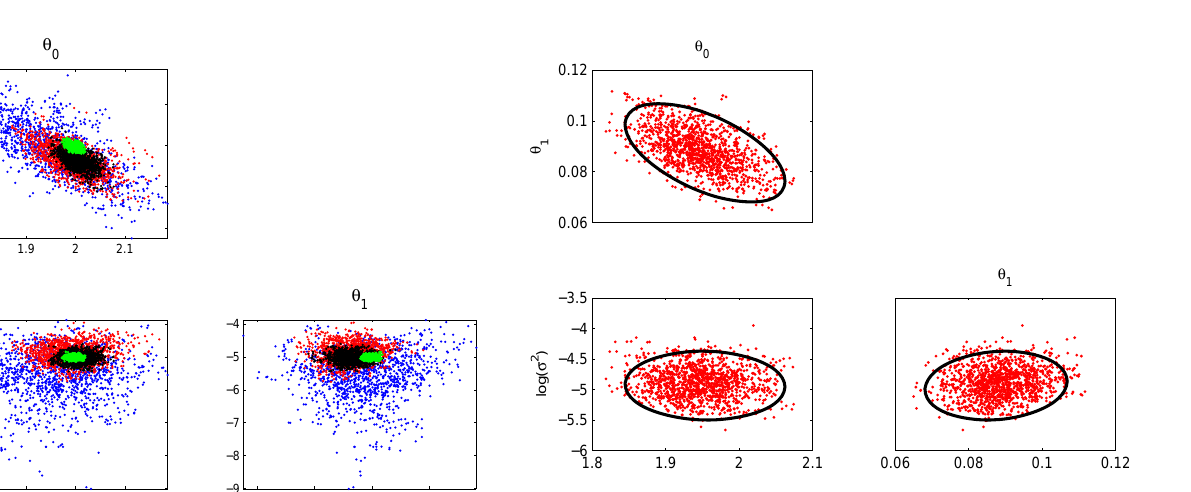
Fig. 5. Posterior distribution using 20 day simulations with MCMC (red dots) and Gaussian approximation (black ellipse).